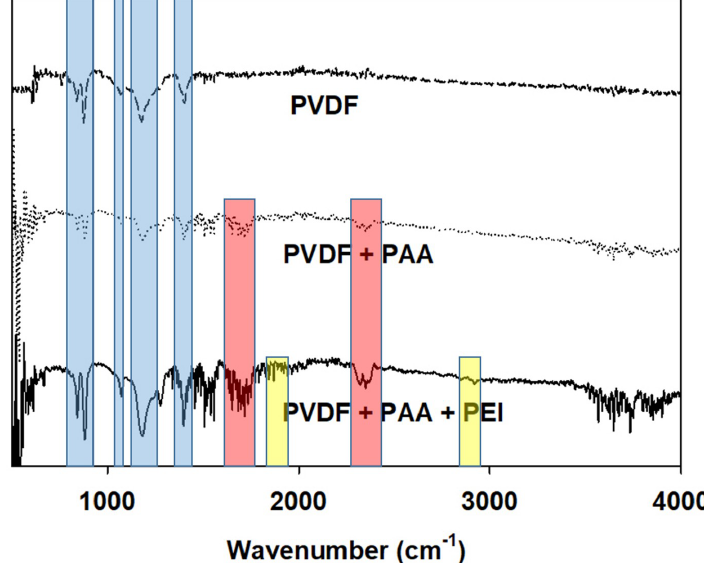
Figure 4. The FTIR spectra of the plain PVDF nanofibers, PVDF/PAA nanofibers, and PVDF/PAA nanofiber with the polyelectrolyte mat with PAA and PEI